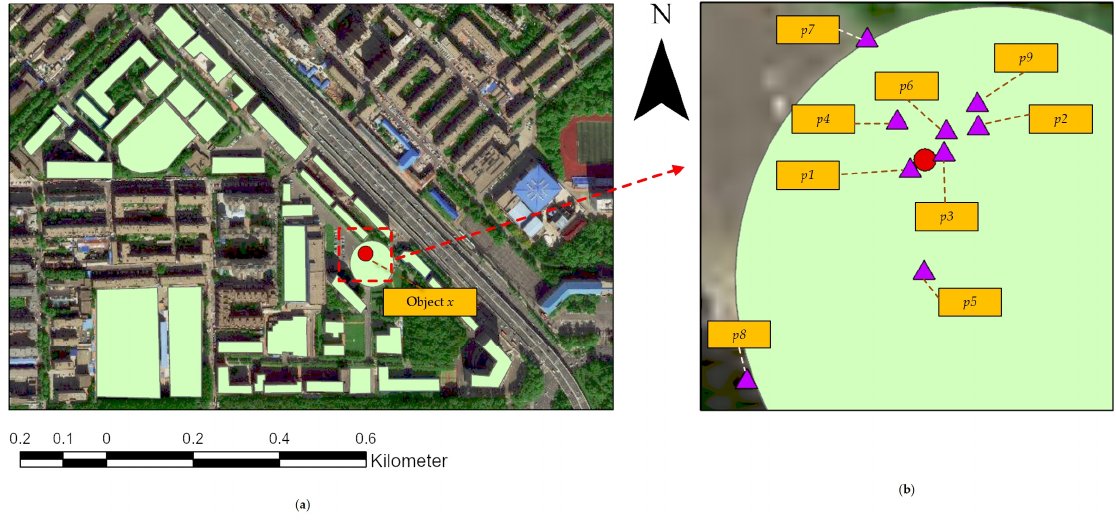
Figure 6. Study area and target; ( a ) study area; ( b ) target object x and corresponding point.